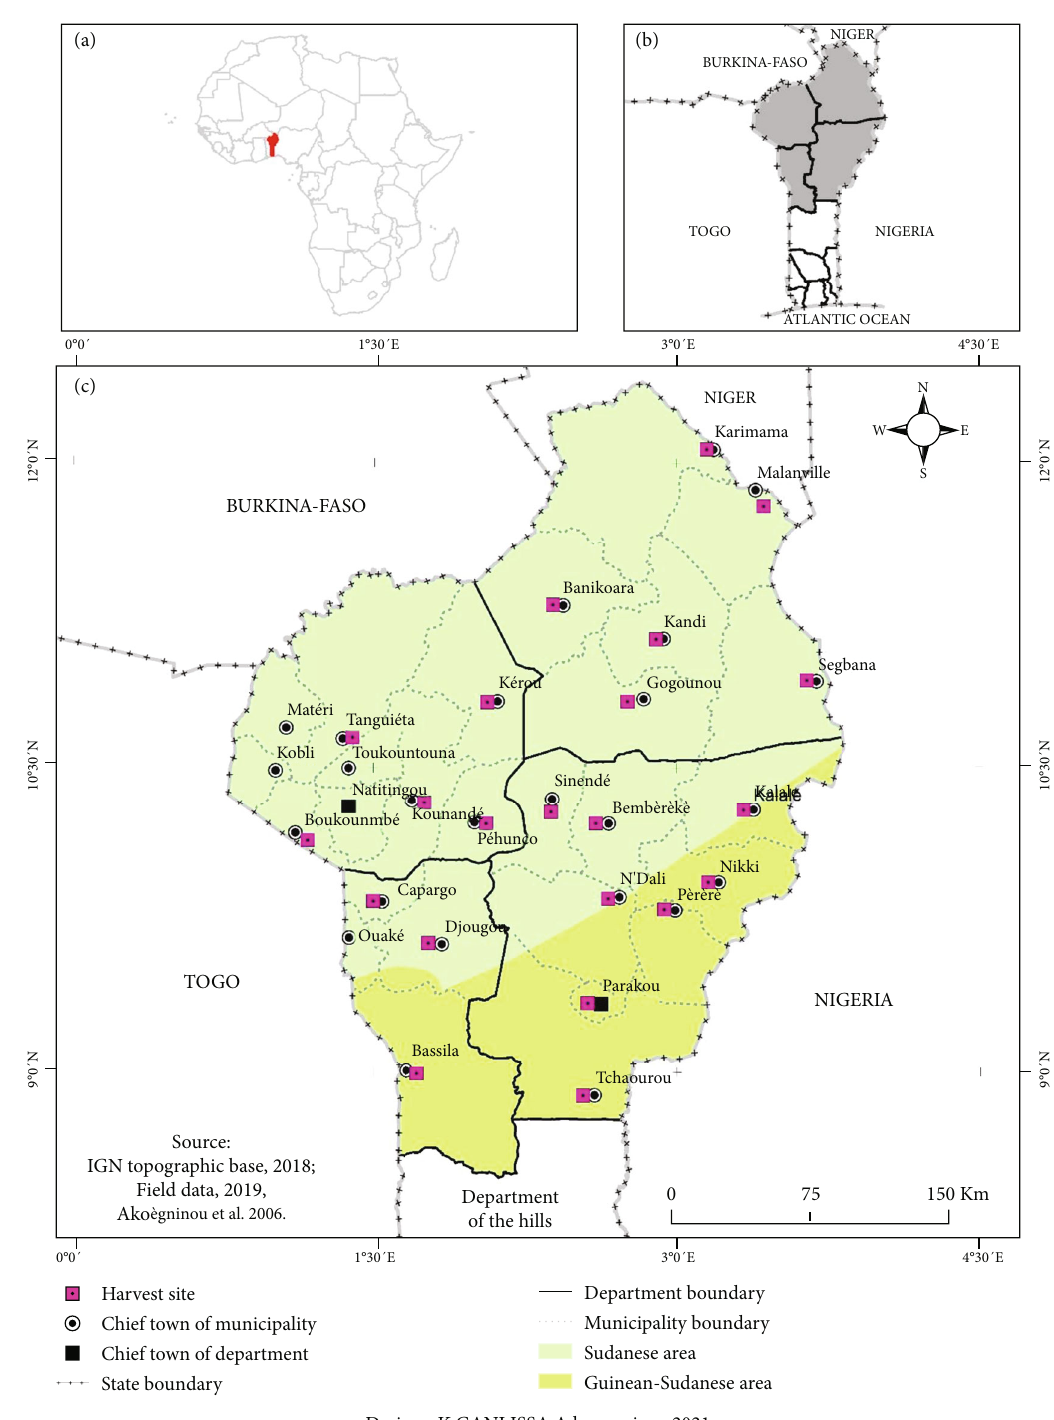
Figure 1: Map of Benin showing Detarium microcarpum seed harvesting